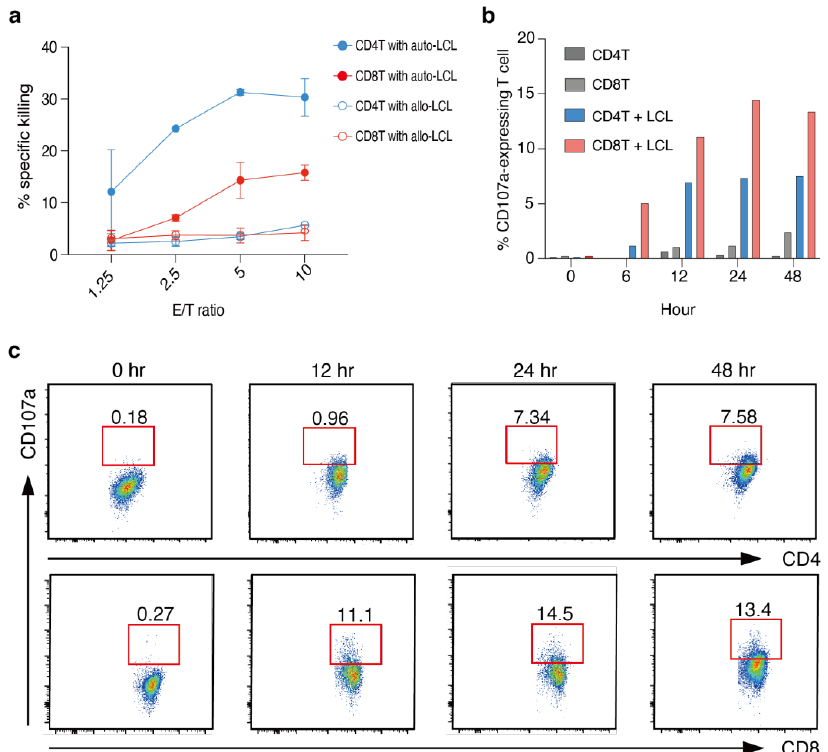
Figure 5. Cytotoxic activity of LCL-specific human CD4 + and CD8 + T cells expanded in culture. CD4 + T cells and CD8 + T cells from HD1 were co-cultured independently for more than 16 days with autologous LCL and assessed with the following experiments. Representative data of more than two independent experiments are shown. ( a ) Cytotoxic activity of LCL-specific CD4 + T cells and CD8 + T cells against autologous LCL or HLA-mismatched LCL at effector to target ratios of 10:1, 5:1, 2.5:1, and 1.25:1. The Mean +/- SEM is depicted for CD4 + and CD8 + T cells on day16 post-culture (n = 2). ( b ) The percentages of CD107a-expressing CD4 + T cells and CD8 + T cells at the indicated time points after re-stimulation with autologous LCL or without re-stimulation. ( c ) Representative profiles of CD107a expression in CD4 + CTL (upper panels) and CD8 + CTL (lower panels) at the indicated time points from re-stimulation. The gate delineates CD107a-positive